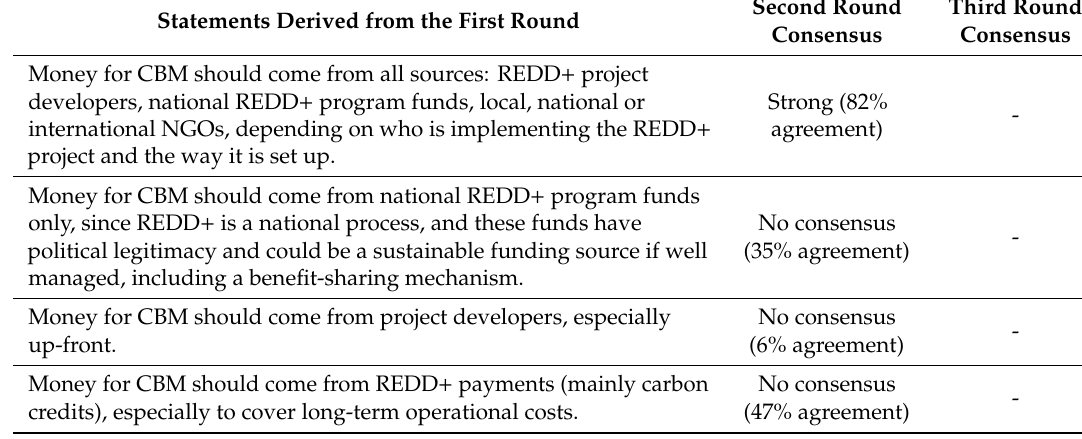
Table 7. Delphi panel results on possible funding sources for the monitoring of REDD + projects in the